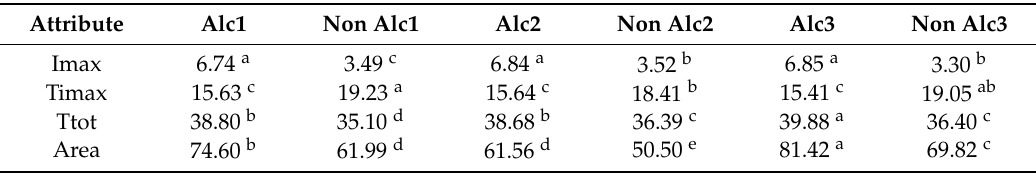
Table 3. Averages of the scores attributed by the time-intensity team to the bitter stimulus in alcoholic and non-alcoholic Pilsen beer